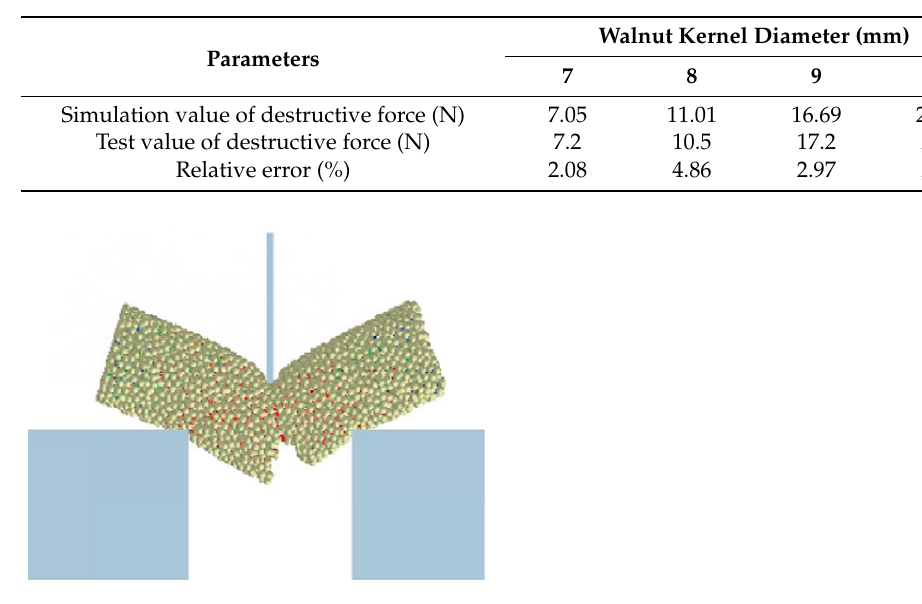
Table 12. The simulation parameters of the walnut kernel used in the EDEM.